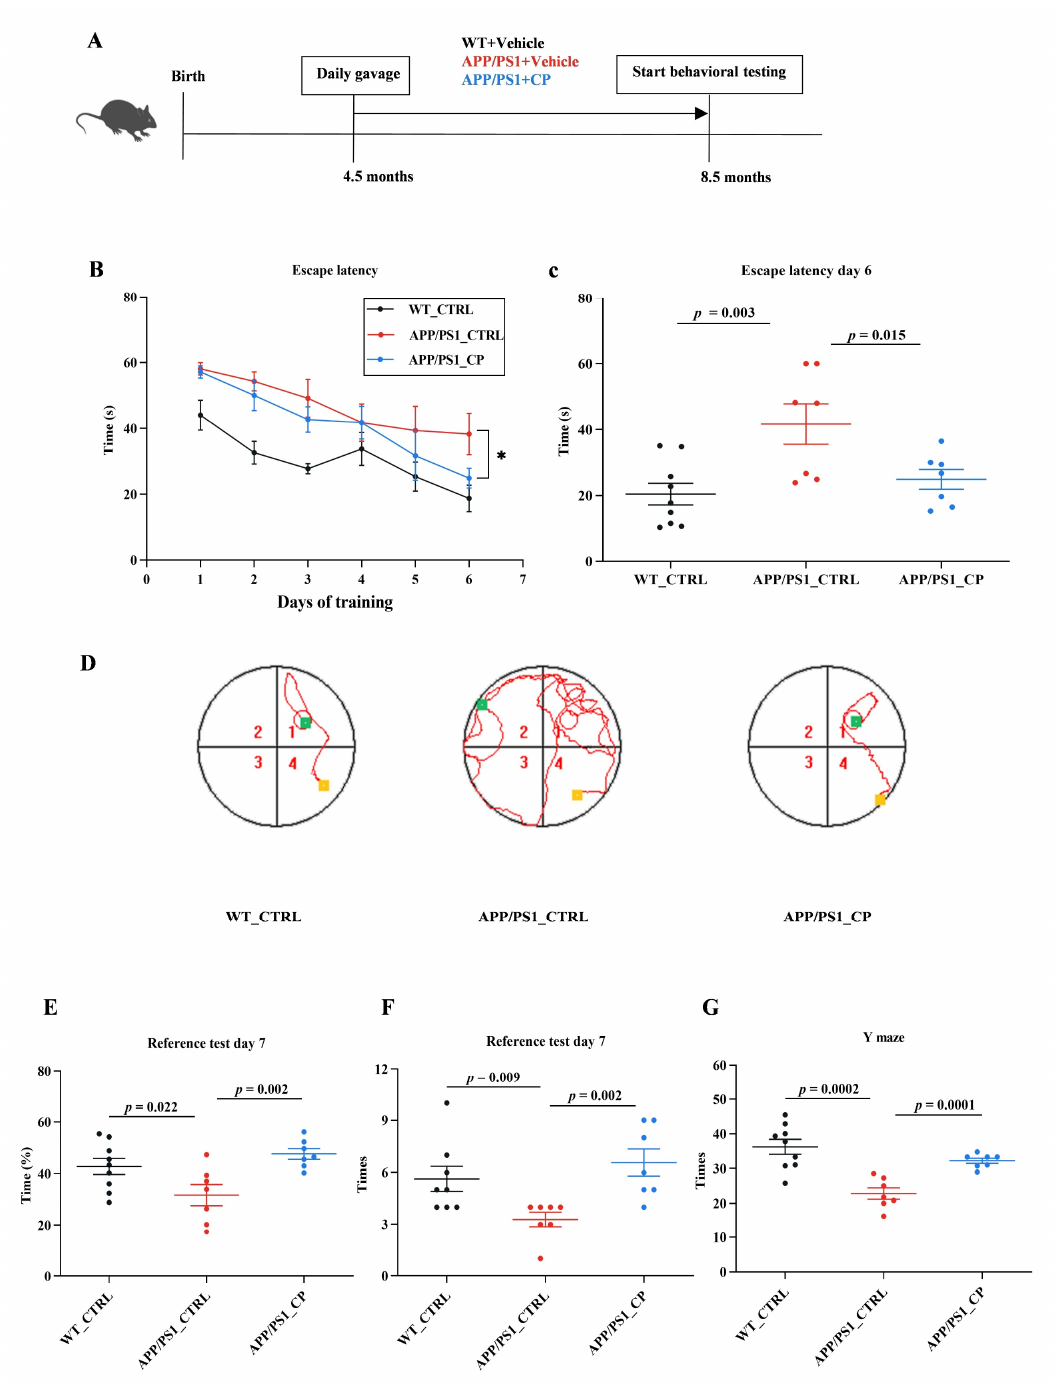
Figure 1. Daily gavage of capsaicin in APP/PS1 mice for 4-month cognitive deficit rescues. ( A ) Dietary capsaicin began at 4.5 month and continued for 4 months (WT_CTRL: n = 9; APP/PS1_CTRL: n = 7; APP/PS1_CP: n = 7). ( B , C ) Both WT and APP/PS1 mice showed learning abilities during the training phase. APP/PS1_CTRL mice showed higher escape latencies during acquisition on day 6 than other groups. ( D ) Representative swimming paths on day 6 of training (Yellow and green separately represent the place of origin and terminal; red line represents swimming paths). ( E ) WT_CTRL mice and APP/PS1_CP mice significantly preferred the target quadrant compared with APP/PS1_CTRL mice. ( F ) The number of mice crossing virtual platforms in the MWM test. ( G ) The Y maze test was used to assess spatial working memory in all animals. All data are the mean ± SEM and the minimum significance value was considered as p < 0.05. * indicates significant